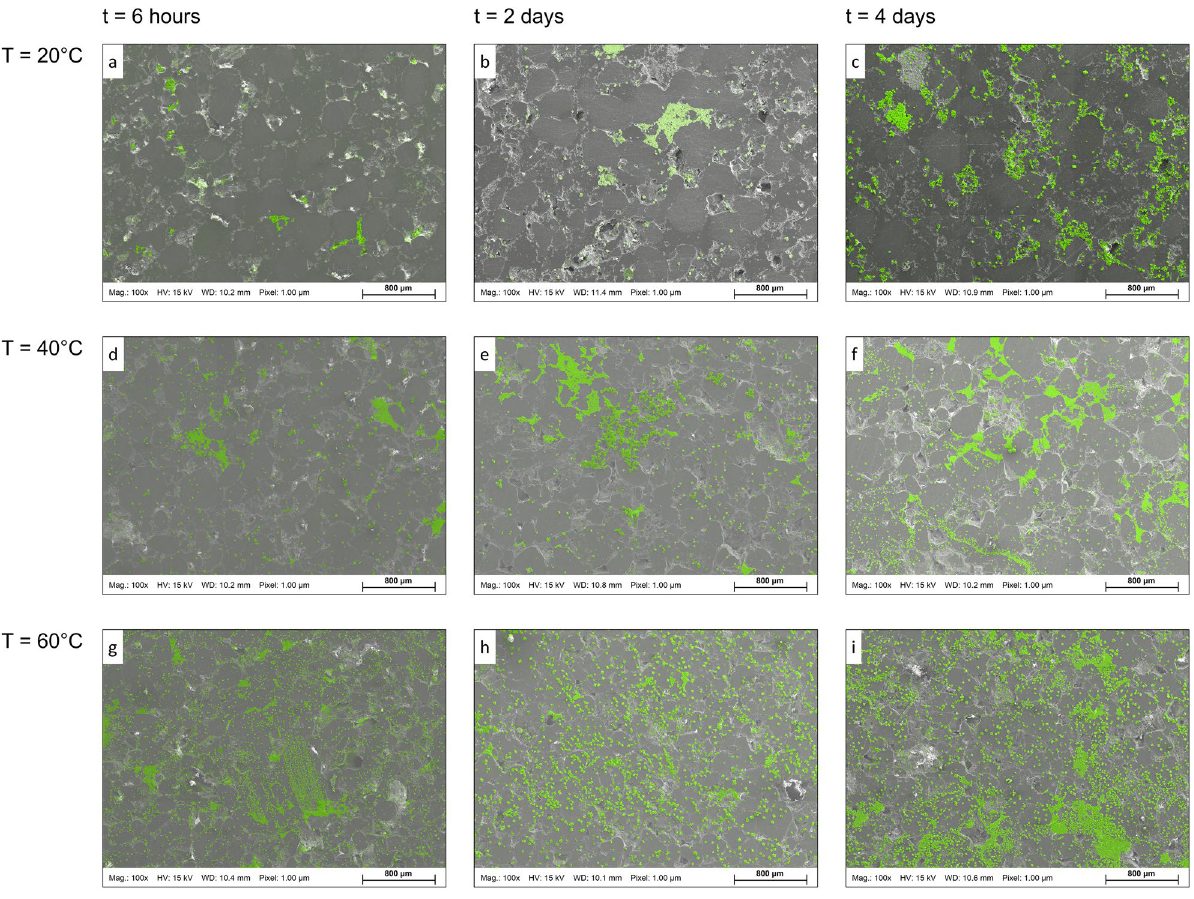
Figure 1. Mosaic maps of calcium carbonate crystal precipitation on the surface of natural quartz-rich sandstone substrates at different temperatures (T) and elapsed times (t) for the 130 × supersaturation experimental set. The mosaic maps demonstrate the superimposed energy-dispersive X-ray spectroscopy (EDS) to identify precipitated crystals (color-coded in green) on top of the backscatter scanning electron microscopy (SEM) micrographs. Each mosaic map covers a 10.5 mm 2 area, with individual pixels representing a 1 µm 2 surface